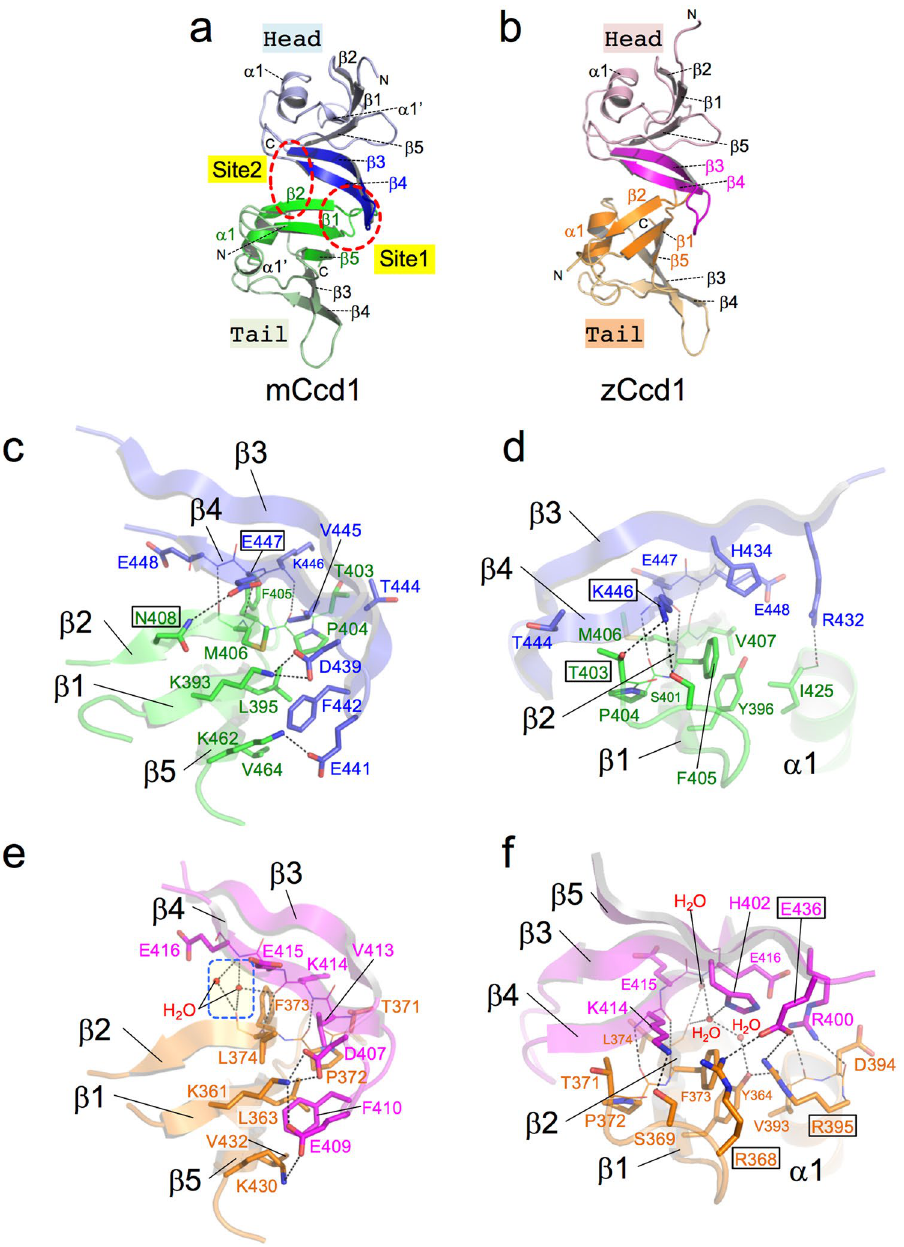
Figure 2. Head-to-tail interaction in Ccd1 helical homopolymers. ( a , b ) Structures of head-to-tail helical homodimers. The head and tail regions in homodimeric interfaces are colored blue and green in mCcd1 ( a ), magenta and orange in zCcd1 ( b ), respectively. Contact sites 1 and 2 in the head-to-tail interface of mCcd1 are indicated by red dashed circles. ( c , d ) Close up views of Site 1 ( c ) and Site 2 ( d ) in mCcd1 homodimer. The head and tail regions are colored blue and green in mCcd1. Hydrogen bonds and salt bridges are indicated by black dashed lines. Residues whose side chains participate in unique hydrogen bond are labeled with boxes. ( e , f ) Close up view of Site 1 ( e ) and Site 2 ( f ) in zCcd1. The head and tail regions are colored magenta and orange. Water-mediated hydrogen bonds between main chains are boxed by a blue dashed line. Residues whose side chains participate in unique electrostatic interactions are labeled with